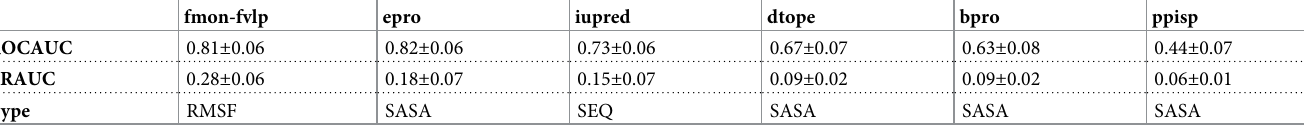
ROCAUC and PRAUC values calculated against two highly conserved HPV epitopes [54,55] are shown for the linear difference of isolated and VLP RMSF (fmon-fvlp), ElliPro scores (epro), IUPred scores (iupred), DiscoTope scores (dtope), BEpro scores (bpro), cons-PPISP scores (ppisp). The primary type of structural